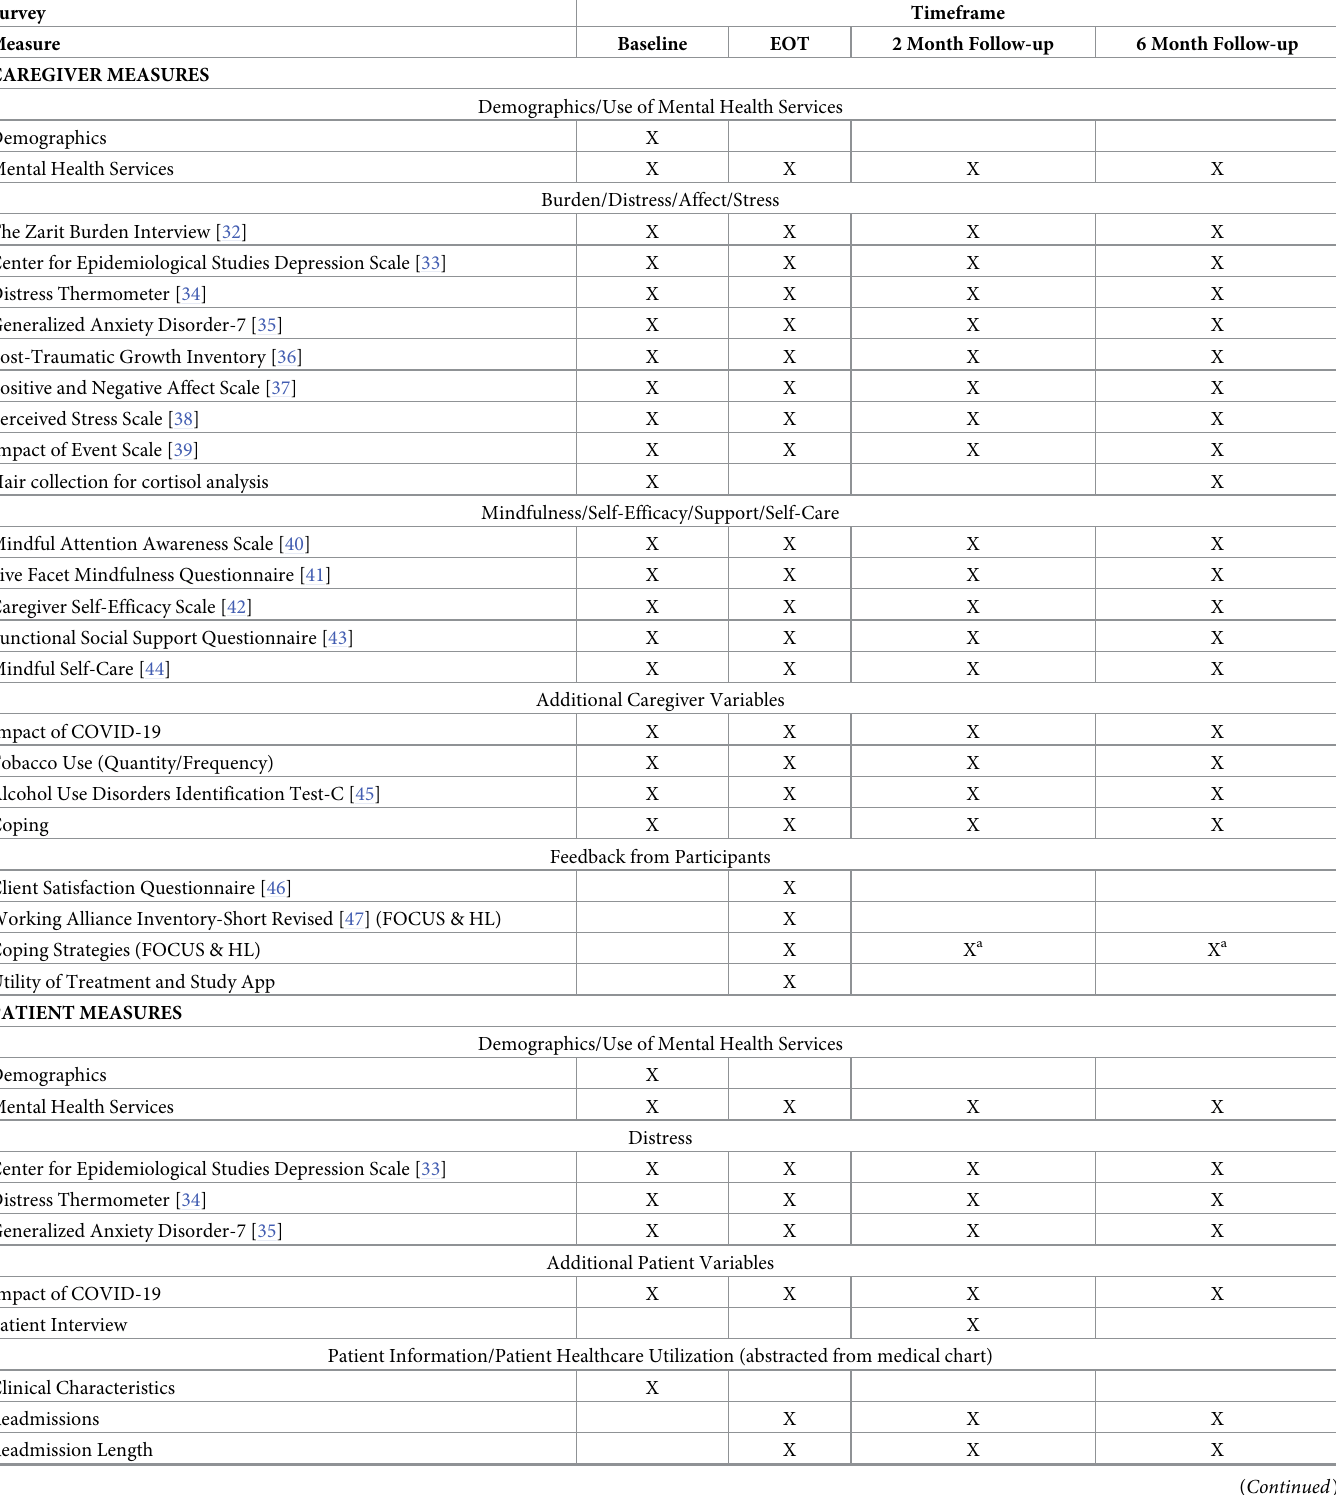
Table 4. Overview of